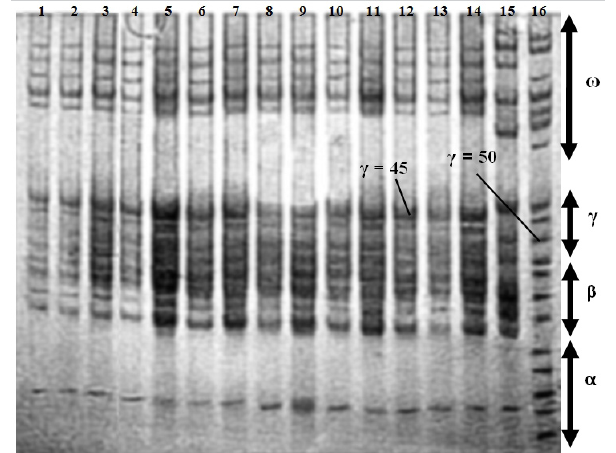
Fig. 1. Example of electrophoretic patterns of gliadin proteins in Bezostaya and the some populations of A. cylindrica . lanes 1 to 14 are various populations of A. cylindrica . lane 15: landrace wheat and lane 16: Bezostaya (as bands were observed in the C8 population, with 13 bands (Tab. 2). In some of the populations, just a fair band in α region was observed (Fig. 1, Tab. 2). However, Gregova et al . (2011) showed that A. cylindrica lacks the α region, which is in contrast with our finding. This may be due to different genotypes used in this study or different method for electrophoresis. In the β region, the highest number of bands were ob- served in the C3, C4, C6 and C7 populations with five bands, while, the lowest number of bands was observed in the C8 population with three bands. In this region, the highest amount of within population diversity (0.15) ob- served for the C4 and C9 populations. However, a number of populations did not show any within population diver-